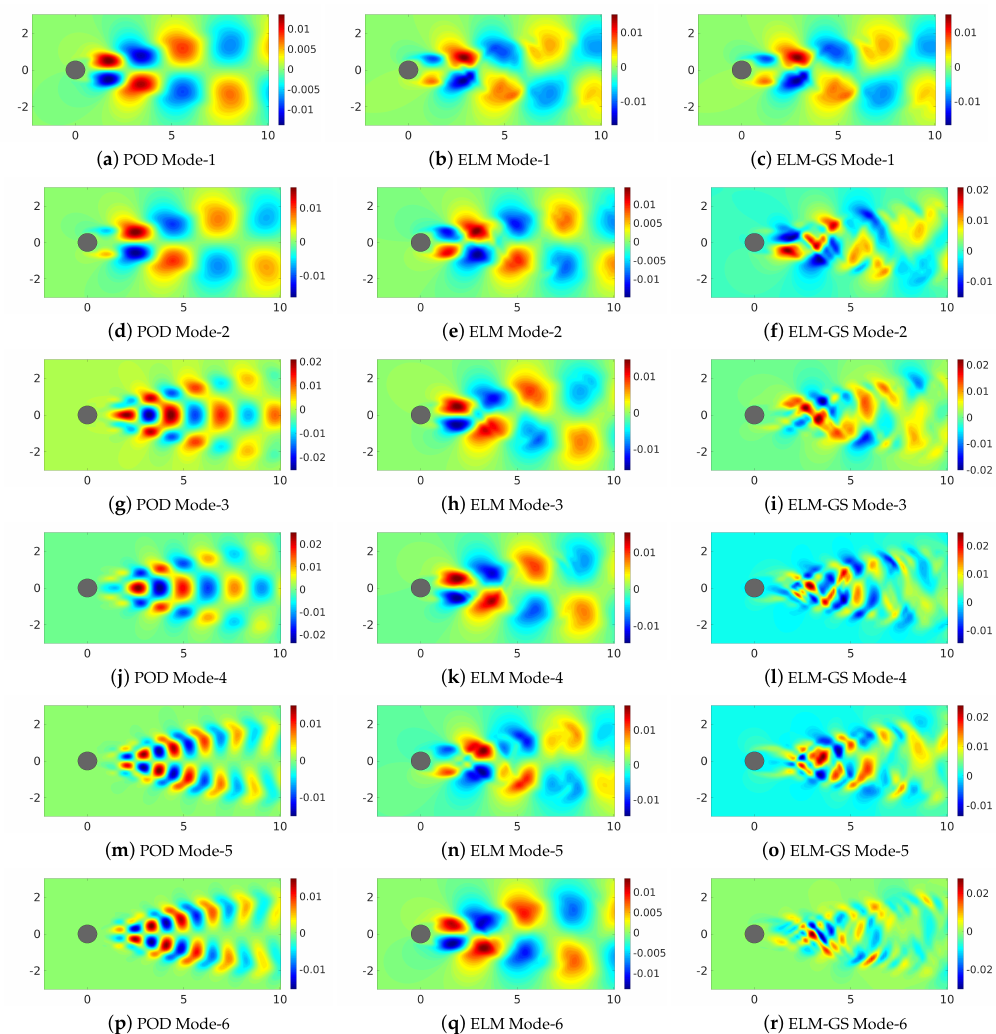
Figure 8. Comparison of the first six modes of POD, ELM and ELM-GS. The POD and ELM-GS share similar structures, possibly due to their underlying orthogonality, while ELM represents repeating structures not unlike POD modes 1 and 2.